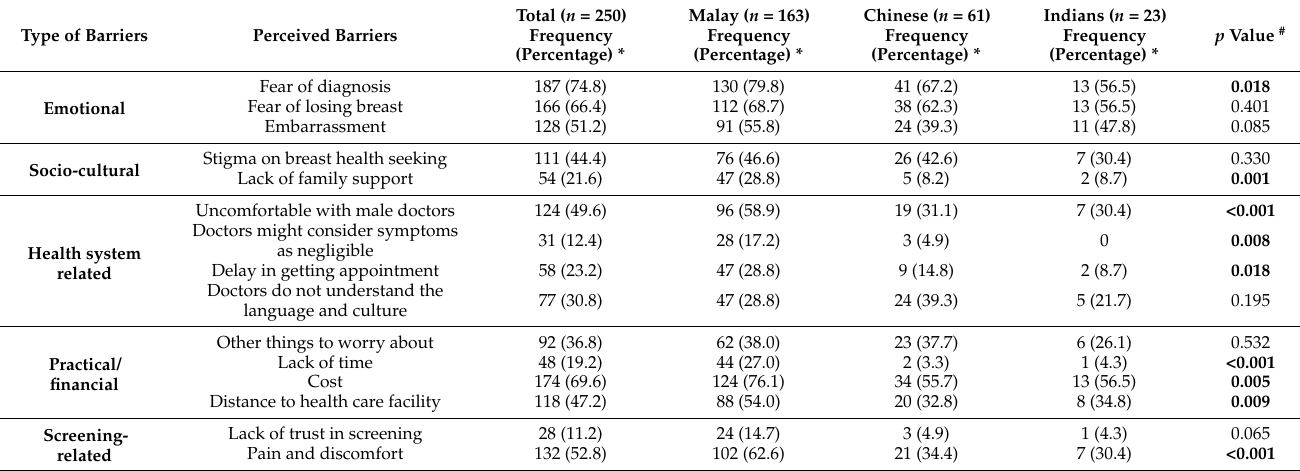
Table 4. Ethnic differences in the perceived barriers for breast cancer screening and breast help seeking. Type of